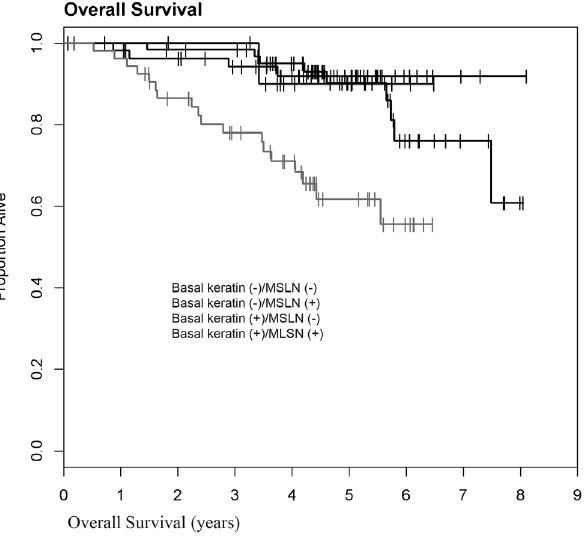
Fig. 6. The difference in overall survival for MSLN( + ) TNBC is independent of basal marker expression (log rank p 5 0.0002, n 5 188). Basal-keratin( + ): CK5/6 and/or CK14 positive; basal-keratin( 2 ): CK5/6( 2 ) and CK14( 2